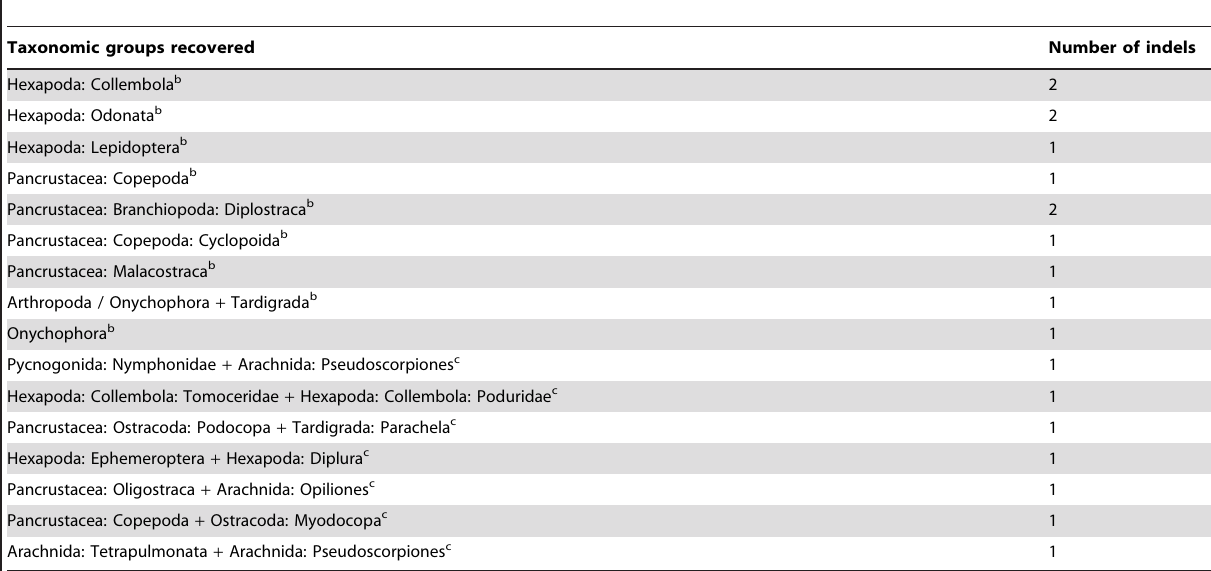
Taxonomic groups